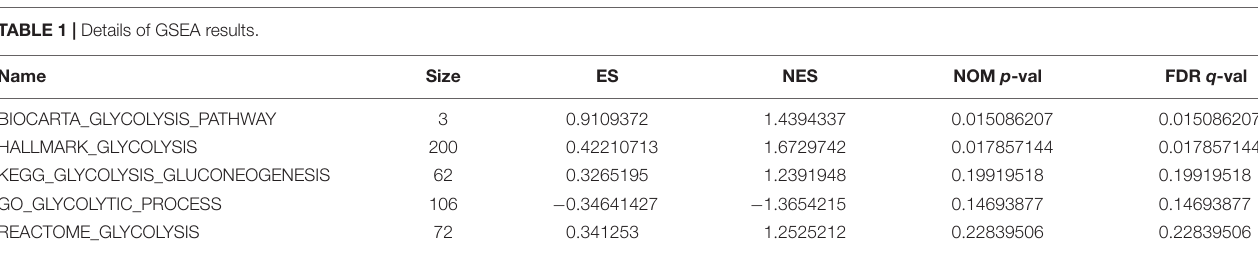
TABLE 1 | Details of GSEA